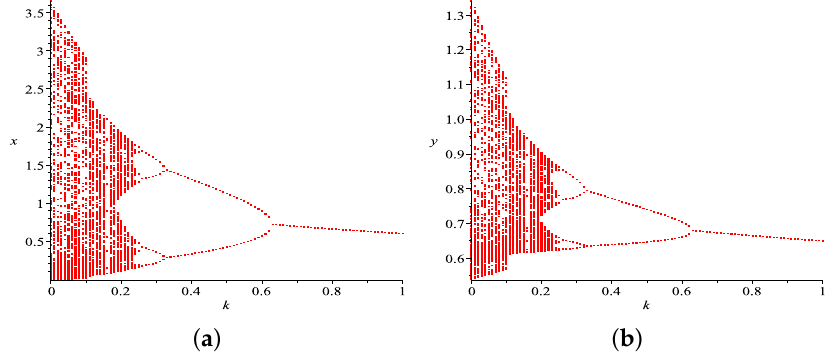
Figure 5. ( a ) The bifurcation plot of prey species corresponding to the bifurcating parameter k , where other parameters are give in (58) and r 0 = 4. ( b ) The bifurcation plot of predator species corresponding to the bifurcating parameter k and r 0 =